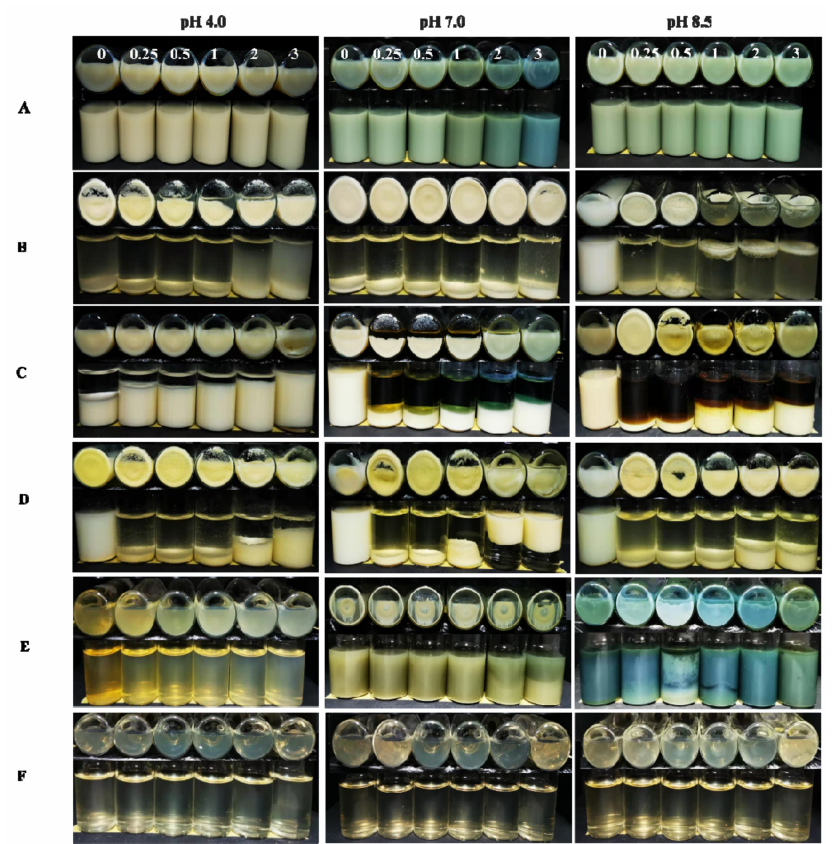
Figure 2. The appearance of dispersions including zein–GA–TA ( A ), zein–GA ( B ), zein–TA ( C ), ZP ( D ), GA+TA ( E ) and GA ( F ) as a function of NaCl concentration (0, 0.25, 0.5 1, 2, 3 mol/L) at pH 4.0, 7.0, or